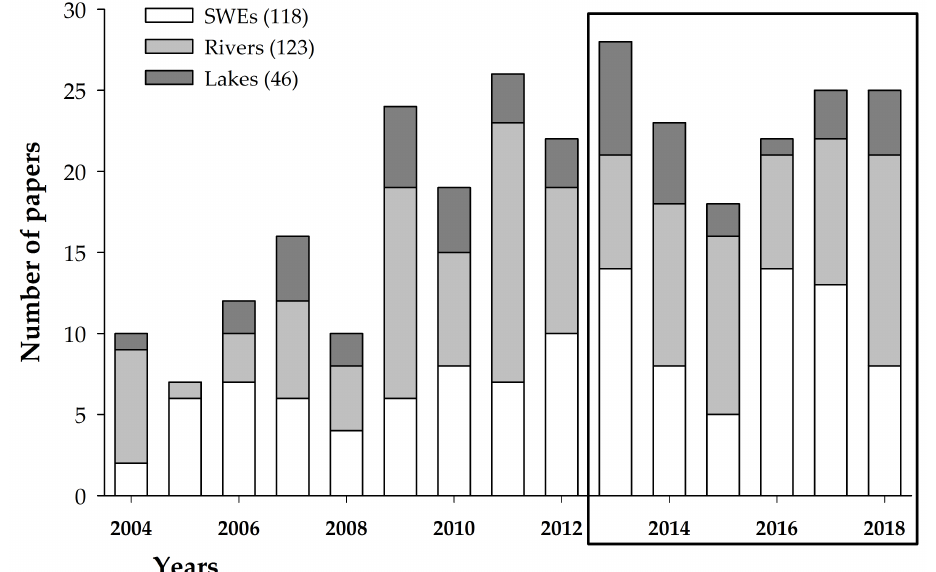
Figure 1. Temporal trend in the number of papers published per year (2004–2018) on “conservation value” OR “ecological value” in relation to habitat typology (SWEs = “wetland OR pond OR pool OR swamp OR “shallow water body””; Rivers = “river OR stream”; and Lakes = “lake OR large water body”). The black box includes the period (2013–2018) over which also rivers and lakes were included in the analysis.